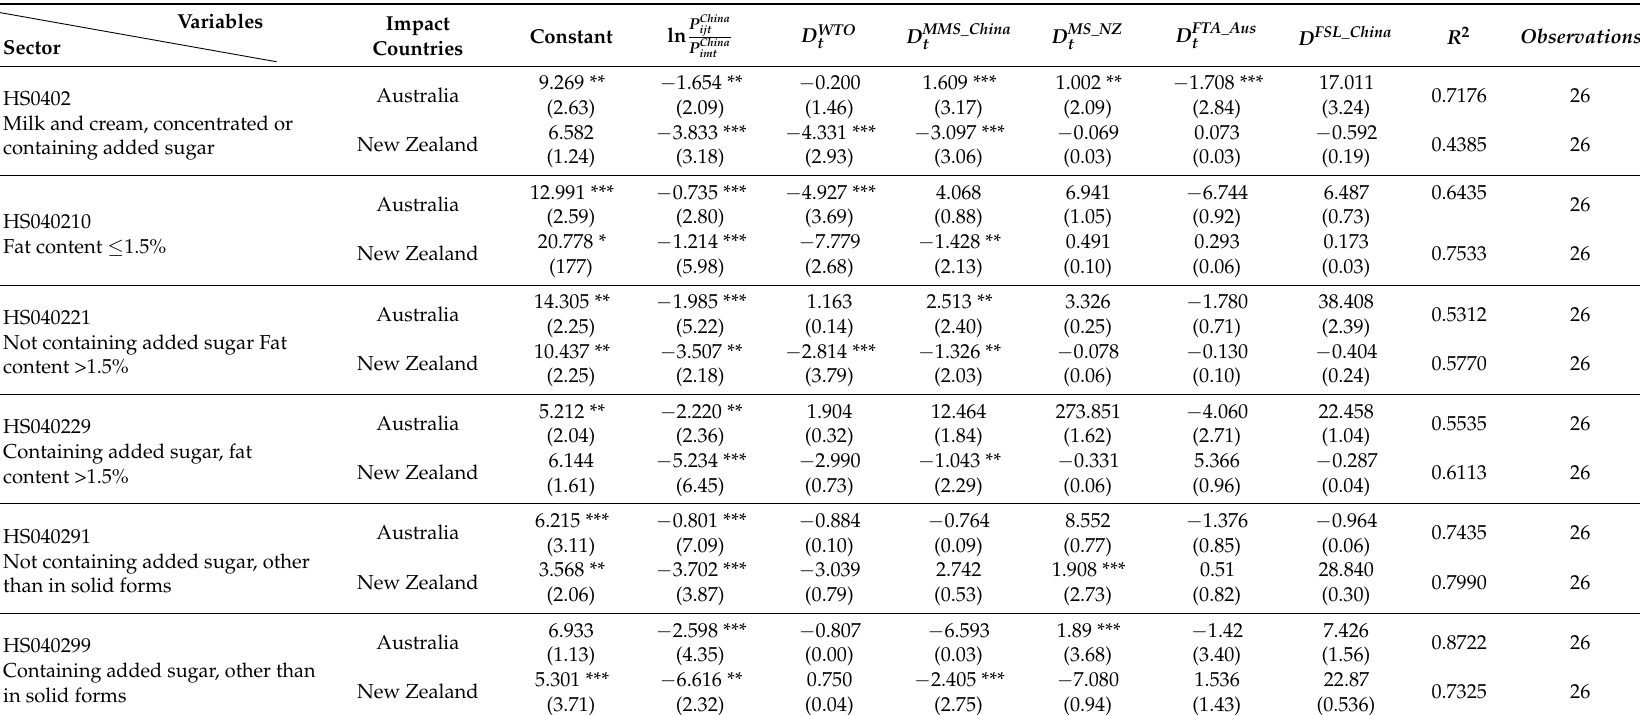
Table 9. Impact of Australia and New Zealand Dairy Products on China imports at Sector HS0402 Using the SUR Model.